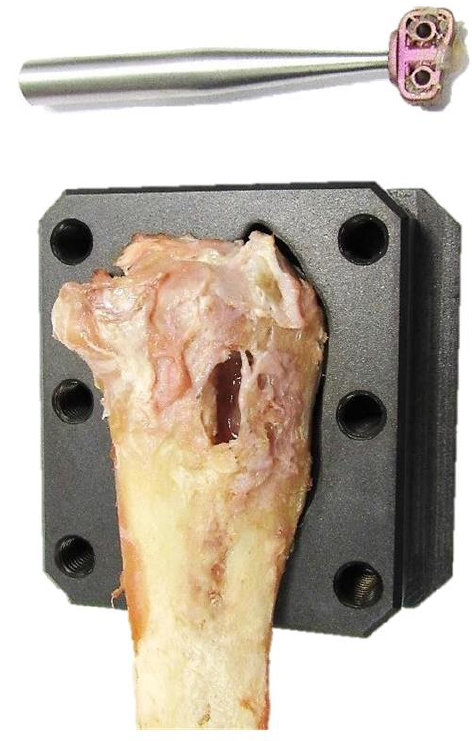
Figure 8. A torn TTA CF implant after biomechanical testing.